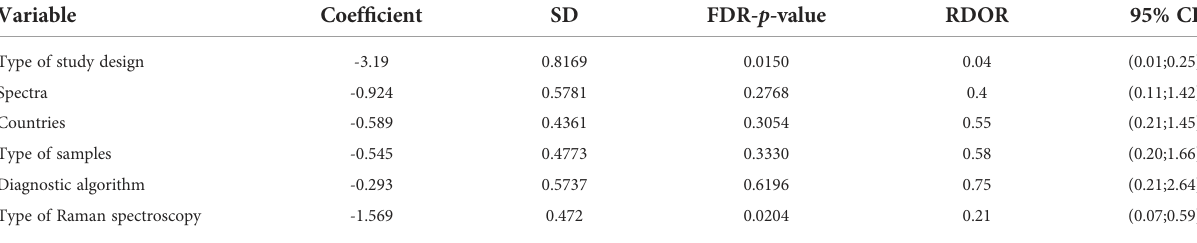
TABLE 2 Result of meta-regression